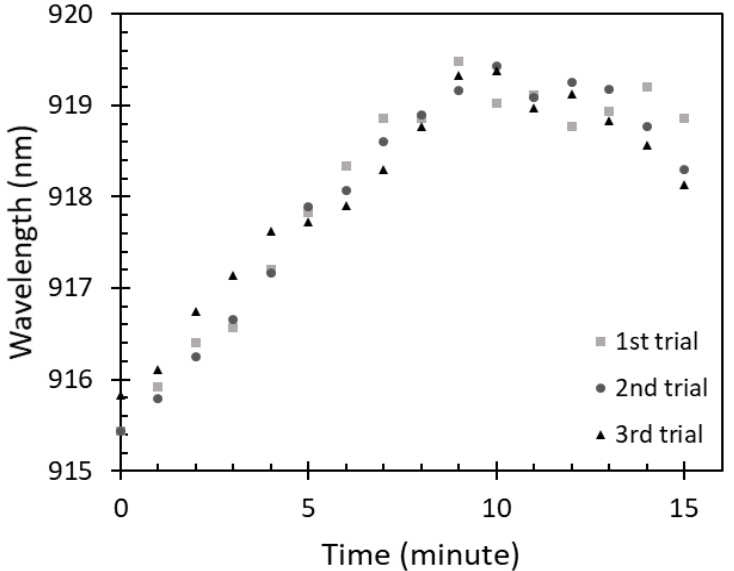
Figure 7. Saturation of 100% IPA vapor absorption on the fiber sensor.